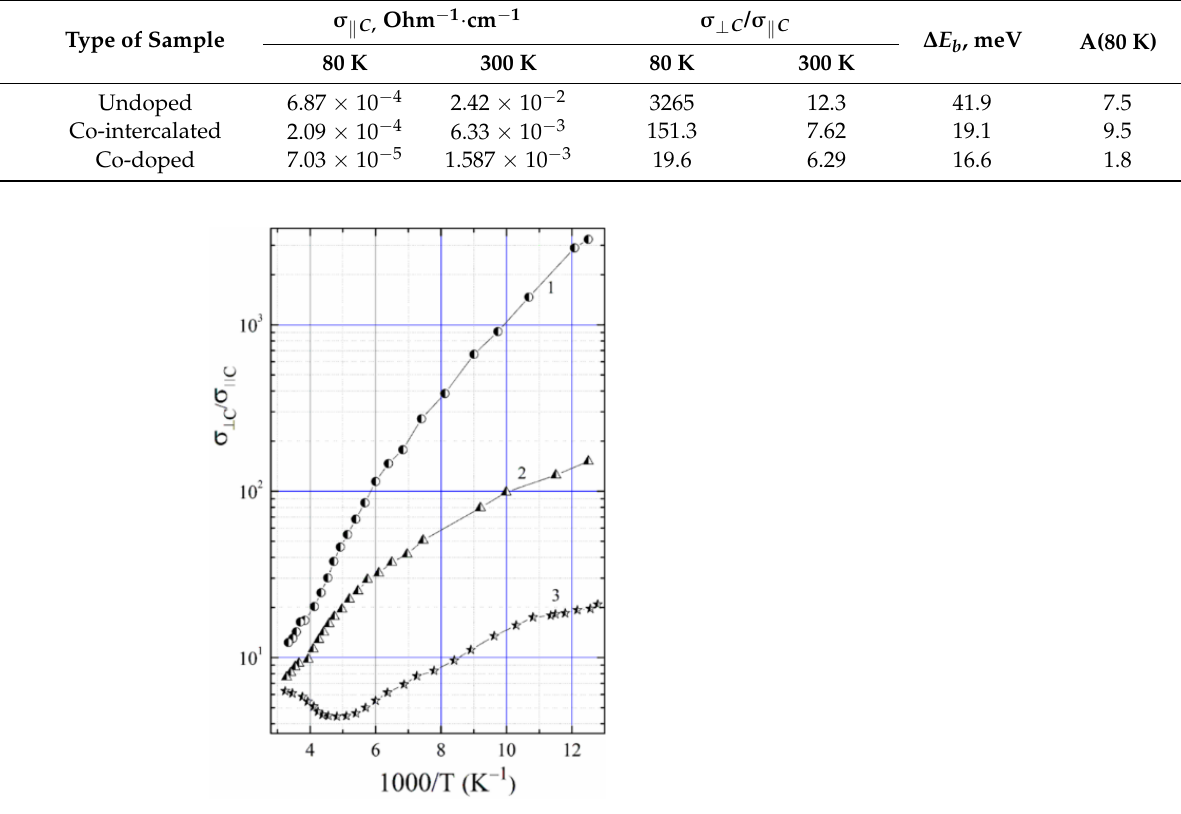
10 of 14 Table 3. Parameters of electrical conductivity anisotropy for different samples of n -type InSe. Sampl е